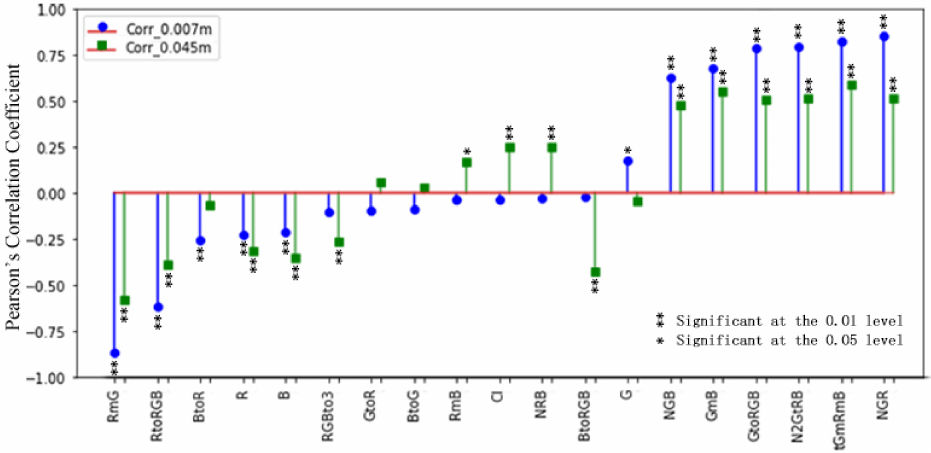
Figure 8. Pearson’s correlation coefficients between LAI_viti and VIs derived from UAV RGB images of 0.007 m (n = 148) and 0.045 m (n = 145) GSD data. The 17 VIs from the multispectral sensor and 19 VIs from the RGB sensor at different spatial resolutions were ranked using the RFE strategy described in Section 2.3.2. Figure 9 shows the VI rankings for 0.007 m GSD data, and Figure 10 shows the rankings of VIs for 0.045 m GSD data. Most of the VIs have stable ranking orders, where the rankings were obtained from 300 repeated experiments. For example, GDVI, GtoR, DVI, CVI, and RmG are mostly highly ranked in 0.007 m GSD data from multispectral sensors, and almost all VIs ranked stably in 0.007 m GSD data from the RGB